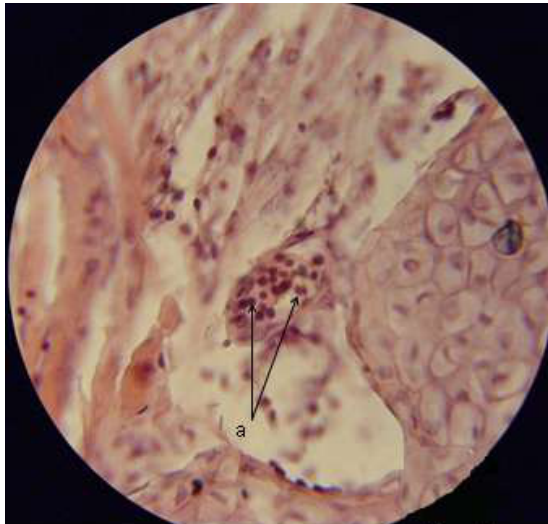
Figure 10: Histological section of gill Cyprinus carpio infected with Branchiomyces spp. , revealing, hyphae containing (a) uninucleate and binucleate progeny of plasmodia. H & E 400 X.